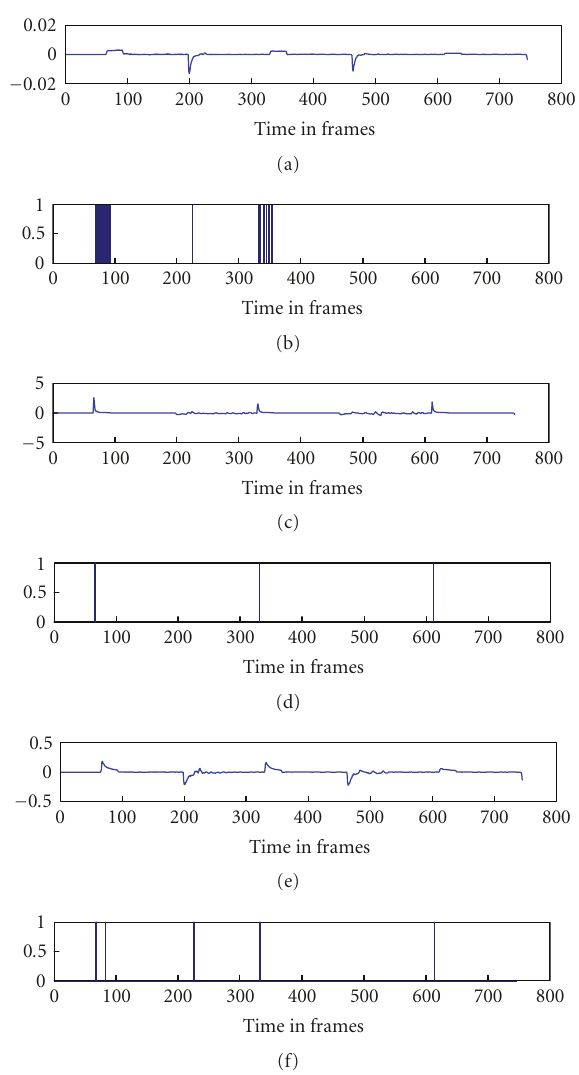
Figure 13: Comparison between the detection functions for the whistle signal (see Figure 9(d)). Plots (a), (c), and (e) are detection ( k ), h o ( k ), and h o ( k ), respectively, and plots (b), (d) and functions h o a r b (f) are the onsets localised correspondingly using these detection functions. The attack of the notes of the whistle signal is not as strong as percussive audio, for example, guitar signal. Detection ( k ) and h o ( k ) are less accurate than h o ( k ) for revealing functions h o a r b the peaks of the onset attack.